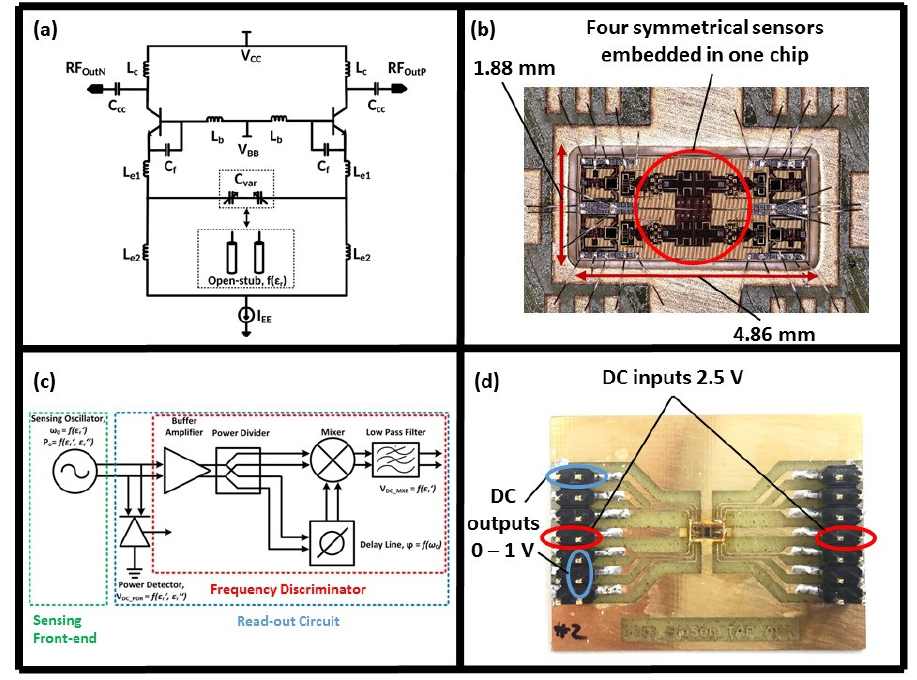
Figure 3. ( a ) Sensor oscillator circuit [30], ( b ) second-generation chip with a quadruple-sensor configuration, ( c ) integration of the DC readout circuit and the sensor on the CMOS platform [31], ( d ) test board of the second-generation dielectric sensor with DC inputs and